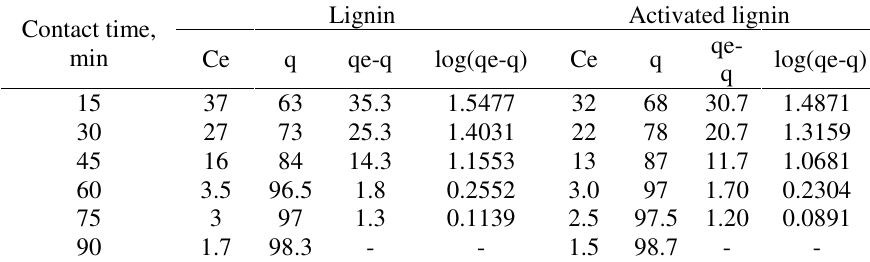
Table 4. Dependence of contact time on Ni(II) adsorption.